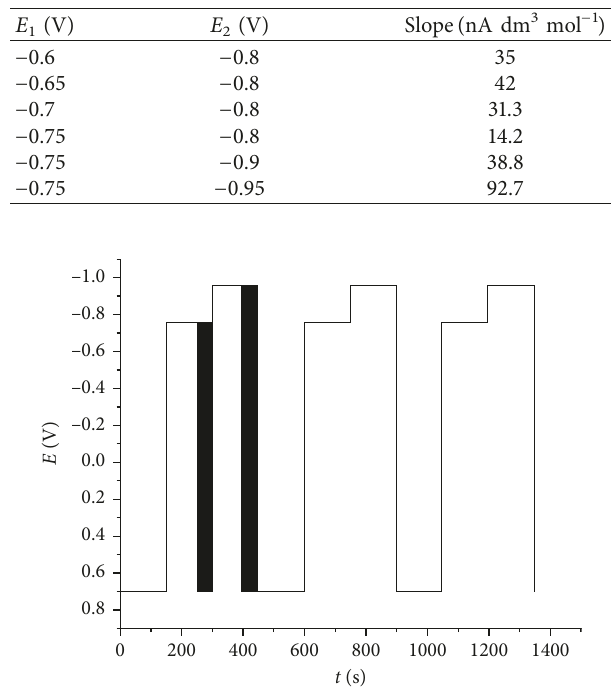
Table 1: Sensitivities at different E